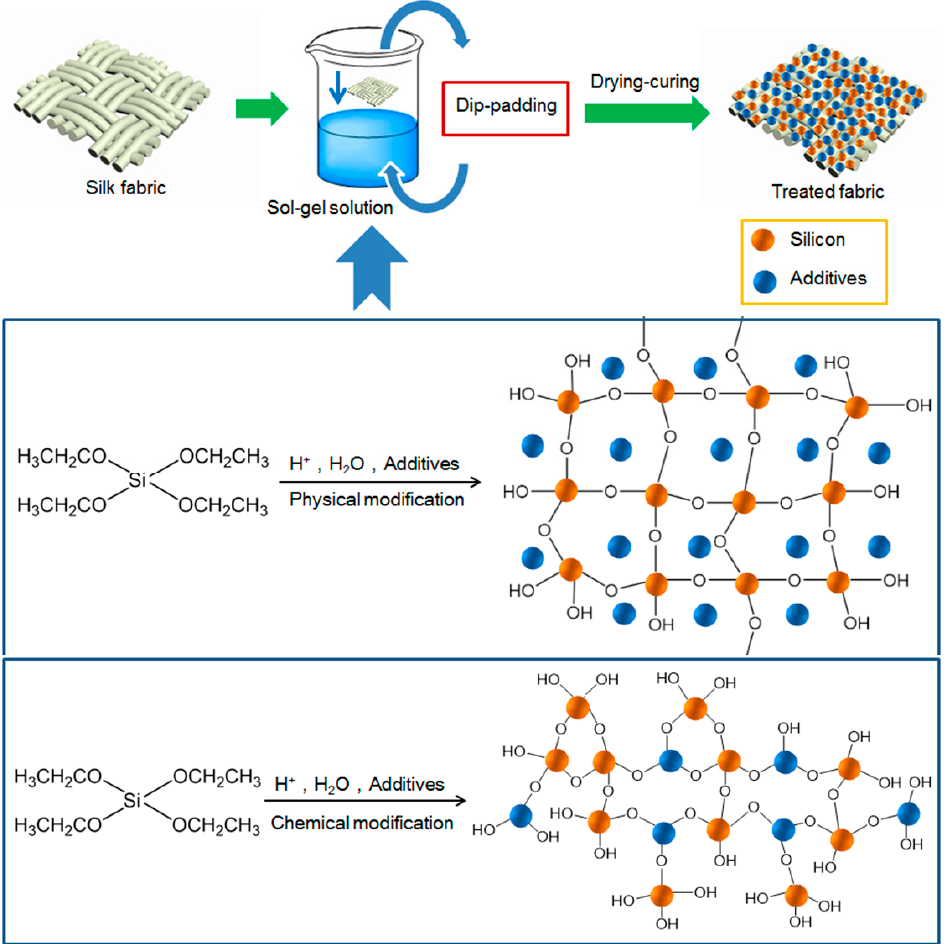
Scheme 1. The schematic diagram of the sol-gel treatments on silk fabrics and the modification of sol-gel.